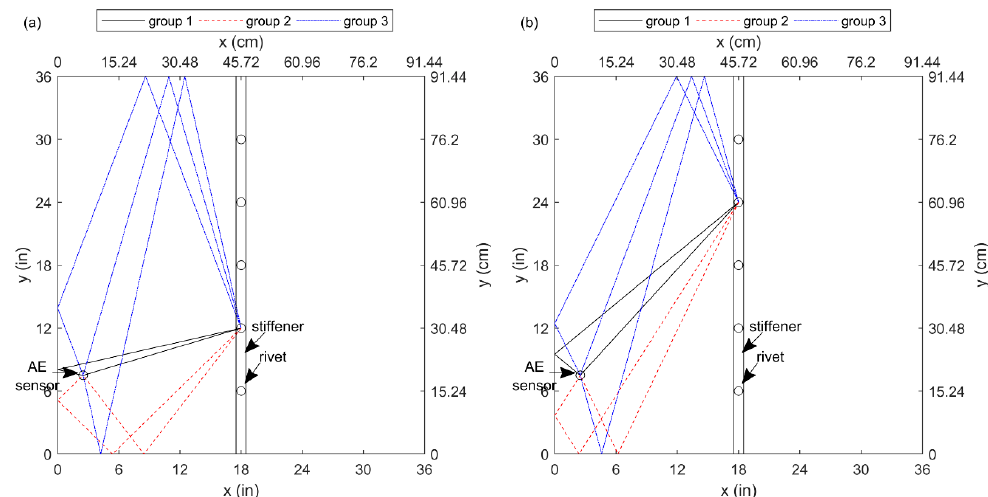
Figure 16. Propagation paths for the left side of the stiffener: ( a ) AE at the second rivet; ( b ) AE at the forth rivet.